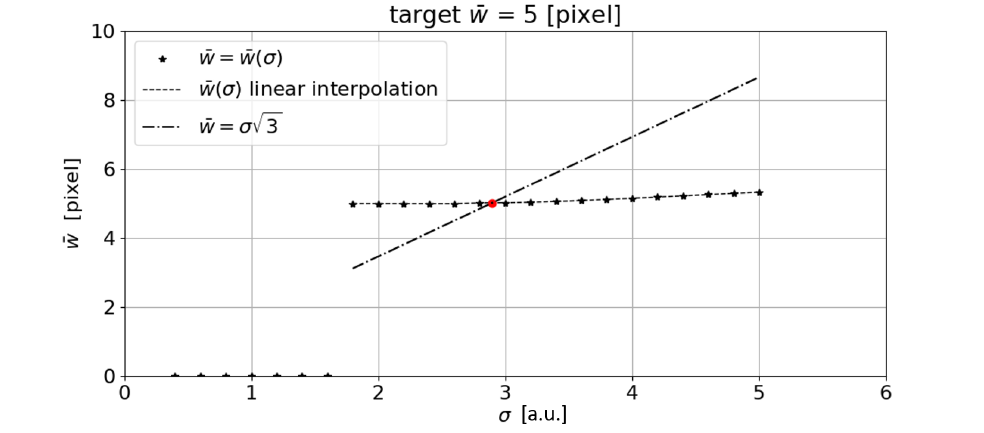
Figure 3. The measured ¯ w ( σ ) (cid:54) = 0 are linearly interpolated, obtaining the ¯ w ( σ ) function (dashed line). Intersecting Steger’s inequality (Equation (4)) with the ¯ w ( σ ) function, returns ¯ w s = 5.019 pixels (corresponding to the red dot). (a.u.: arbitrary unit).